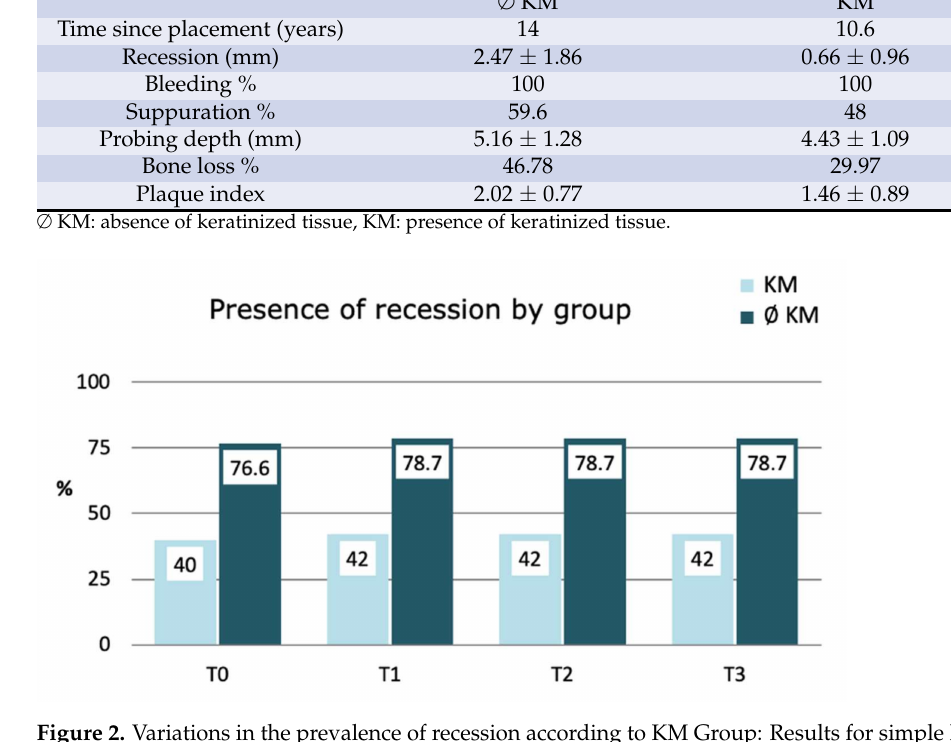
Figure 2. Variations in the prevalence of recession according to KM Group: Results for simple logistic regression with GEE model.